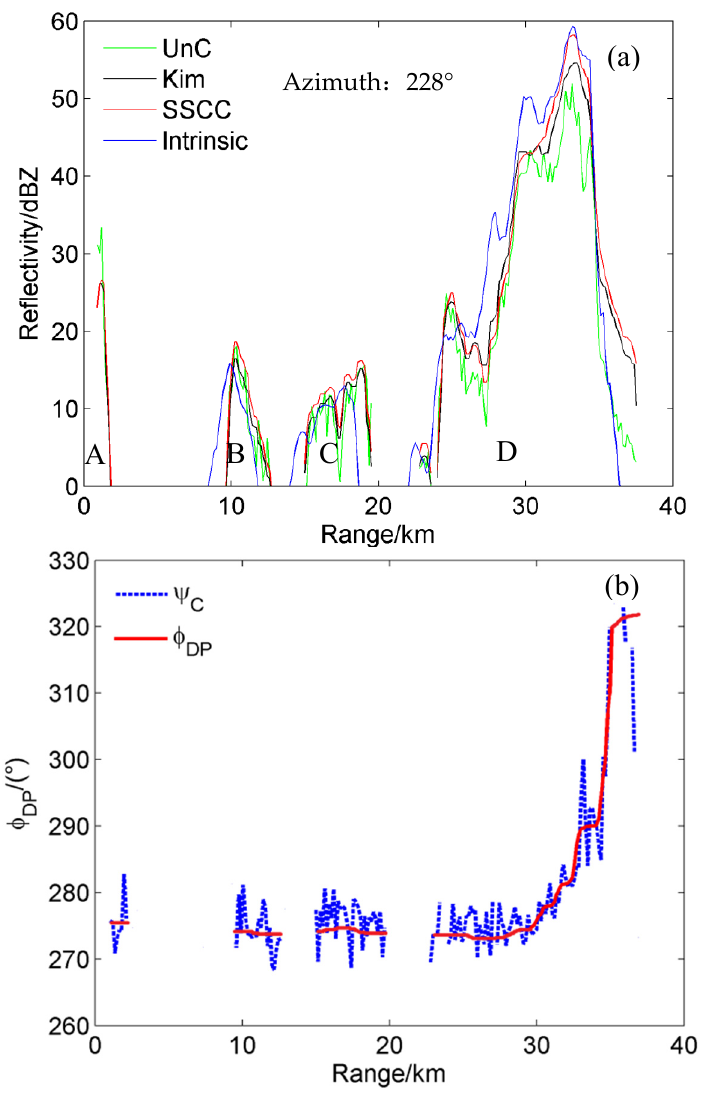
Figure 8. ( a ) Range profile of different reflectivity along the azimuth of 228°, uncorrected reflectivity (UnC), reflectivity corrected by Kim et al.’s method (Kim), reflectivity corrected by the SSCC method (SSCC) and the intrinsic reflectivity (Intrinsic); ( b ) the measured Ψ C and the filtered φ DP .